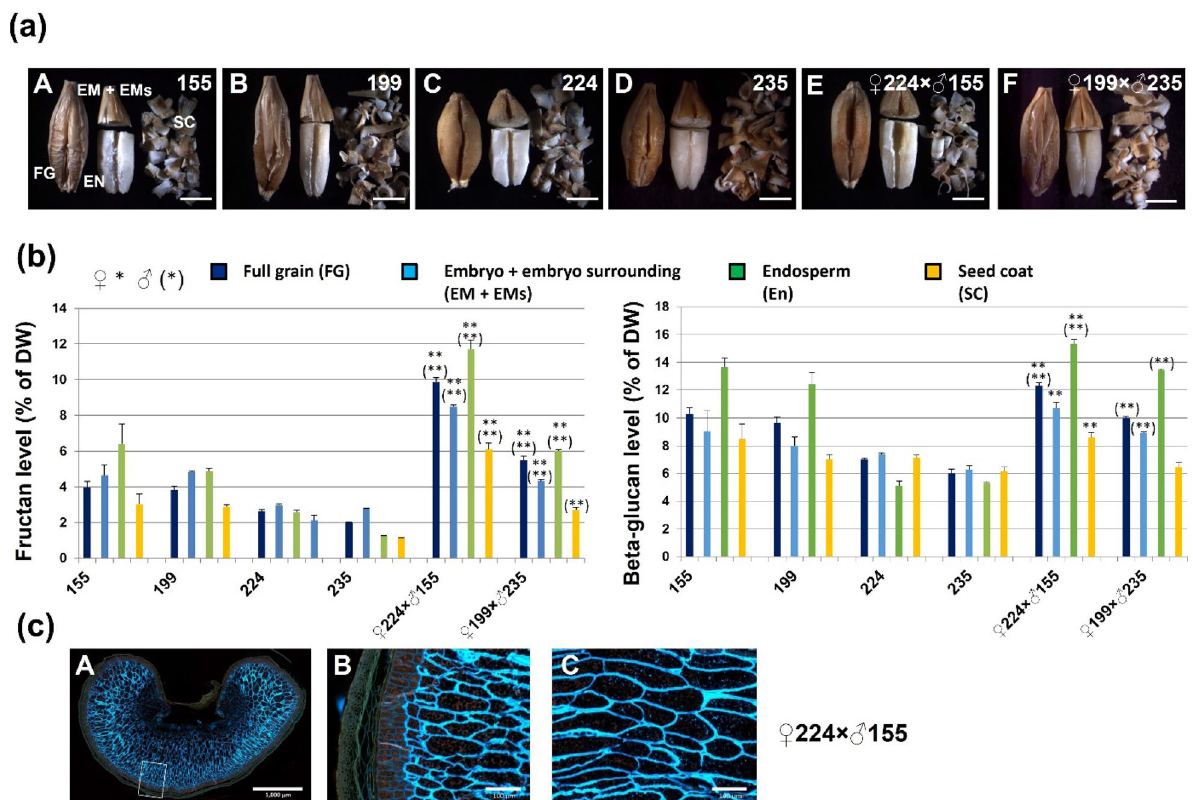
Figure 5. Fructan and beta-glucan levels and microstructure of different tissues in high fructan grain. ( a ) Images of the front side (A–F) of a full grain (FG, dehusked), embryo (EM), embryo-surrounding tissue (EM + Ems), endosperm (EN), and seed coat (SC). Tissues of barley lines 155, 199, 224, 235, 224 × 155 and 199 × 235 were hand-dissected using a razor blade. ( b ) Percentage of fructan and beta-glucan per unit dry weight (DW) in the different tissue fractions of the barley lines. A good correlation between fructan and beta-glucan content was found in full grain and all three tissues (Pearson correlation coefficient ( r ) = 0.9121). ( c ) Microscopic images of the microstructure in high-fructan grain line 224 × 155. Photographs of cross-sections of full grains (A). Close-ups of the corresponding boxed region (B, C) in the images (A), respectively. Student’s t-test was used (Error bars show SD). * P < 0.05 and ** P < 0.01 or (*) P < 0.05 and (**) P < 0.01 in ( b ) are shown for significant differences between the progenies and the maternal or paternal line, respectively. Three biological replicates